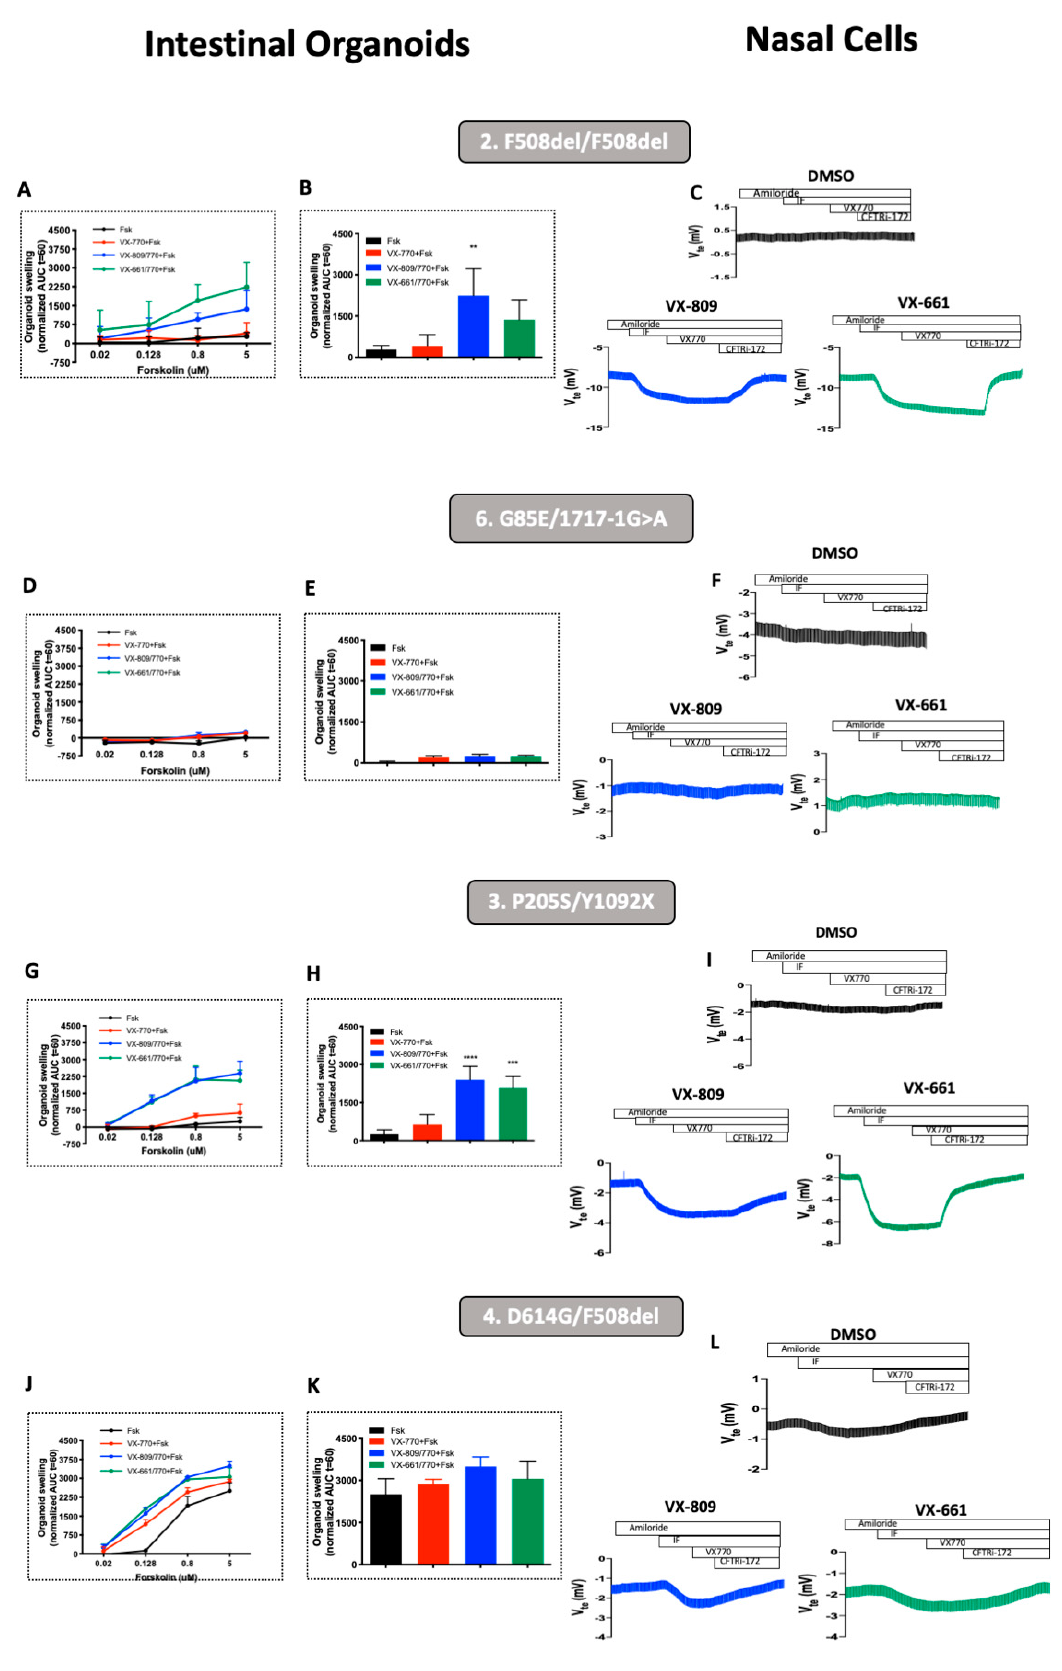
Figure 3. Comparison of CFTR rescue by CFTR modulators in pHNEs and intestinal organoids. Measurements of CFTR rescue by CFTR modulators show similar rescue in pHNEs and intestinal organoids from the same individual.